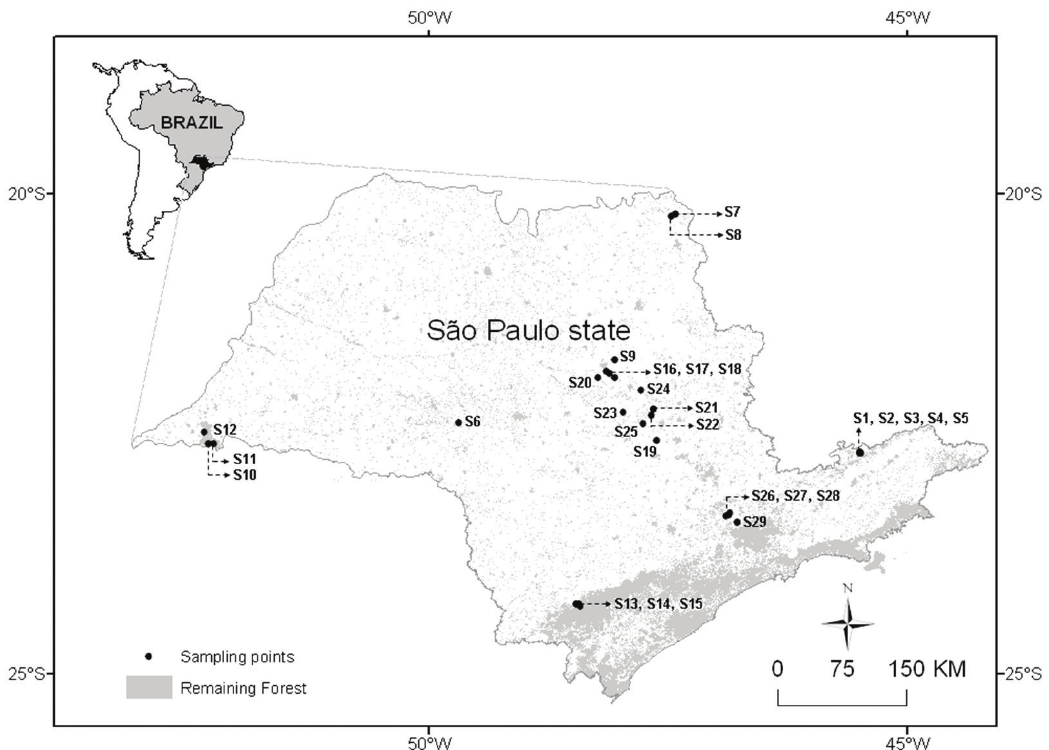
Figure 1. Map of São Paulo State indicating the stream sampling sites: Parque Estadual de Campos de Jordão (S1, S2, S3, S4 and S5), Estação Ecológica Caetetus (S6), Parque Estadual Furnas do Bom Jesus (S7 and S8), Parque Estadual de Vassununga (S9), Parque Estadual Morro do Diabo (S10, S11 and S12), Parque Estadual Intervales (S13, S14 and S15), sugarcane cultivation (S16, S17, S18, S19 and S20); pasture (S21, S22, S23, S24 and S25) and eucalyptus plantations (S26, S27, S28 and